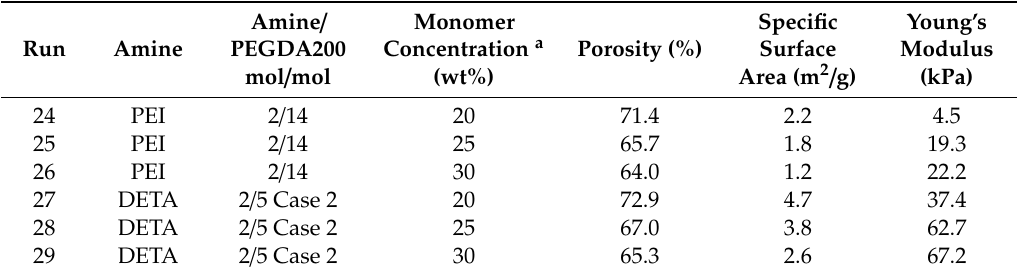
Table 4. Structure and mechanical properties of PEI or DETA-PEGDA200 dry porous polymers. Amine Run Amine